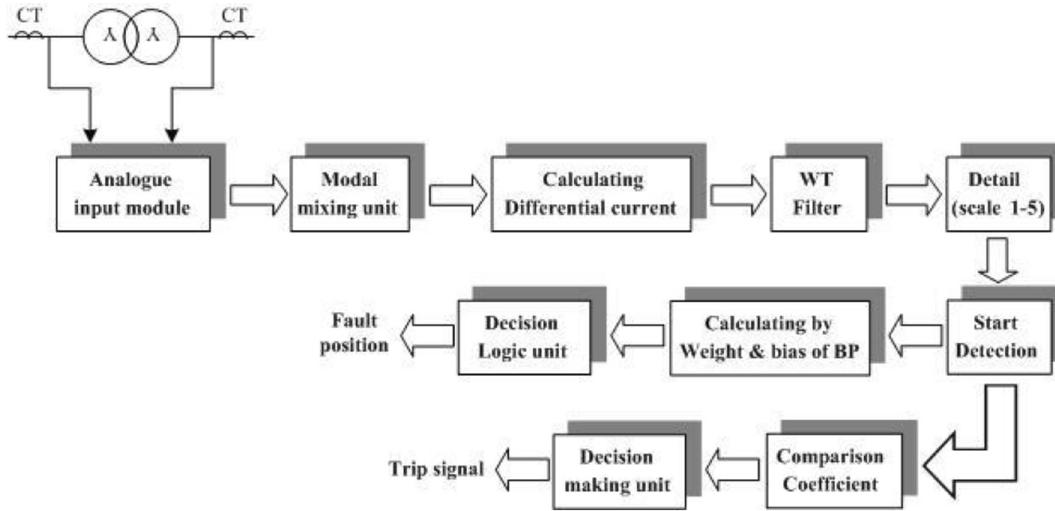
Figure 1. Diagram of power transformer fault detection and location